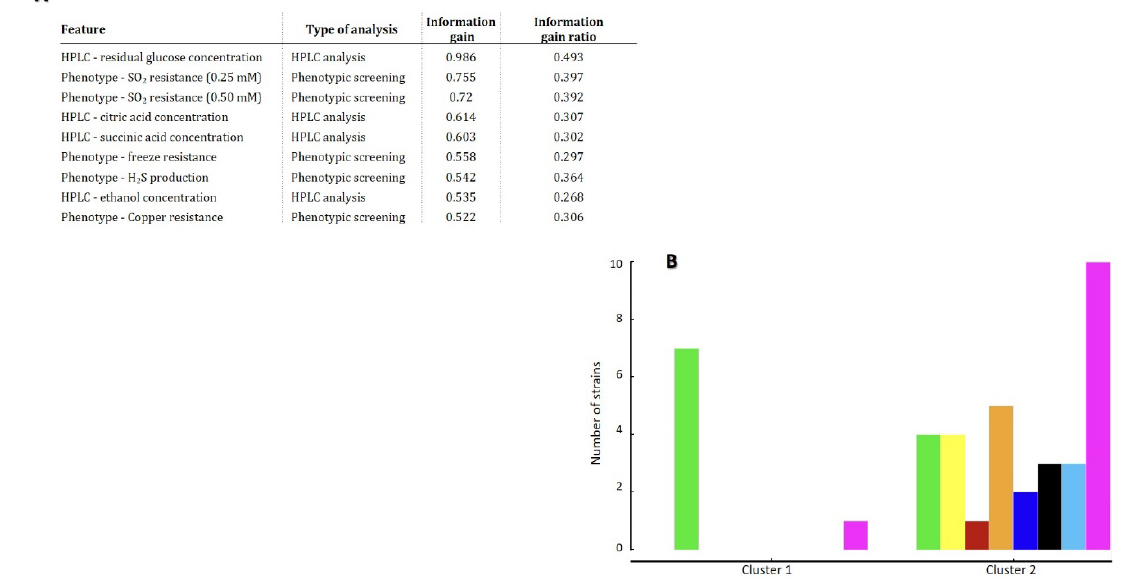
Figure 3. k-means cluster analysis of T. delbrueckii strains’ characterization. ( A ) Features (phenotypic tests and metabolites quantified by HPLC) mostly contributing for the division of strains into two clusters, in terms of information gain and information gain ration; ( B ) Number of strains categorized in the two clusters defined with k-means algorithm, colored according with their technological application or origin: ● —winemaking; ● — arboreal/soil; ● —food; ● —bread; ● —water; ● —clinical; ● —other beverages; ● —unknown